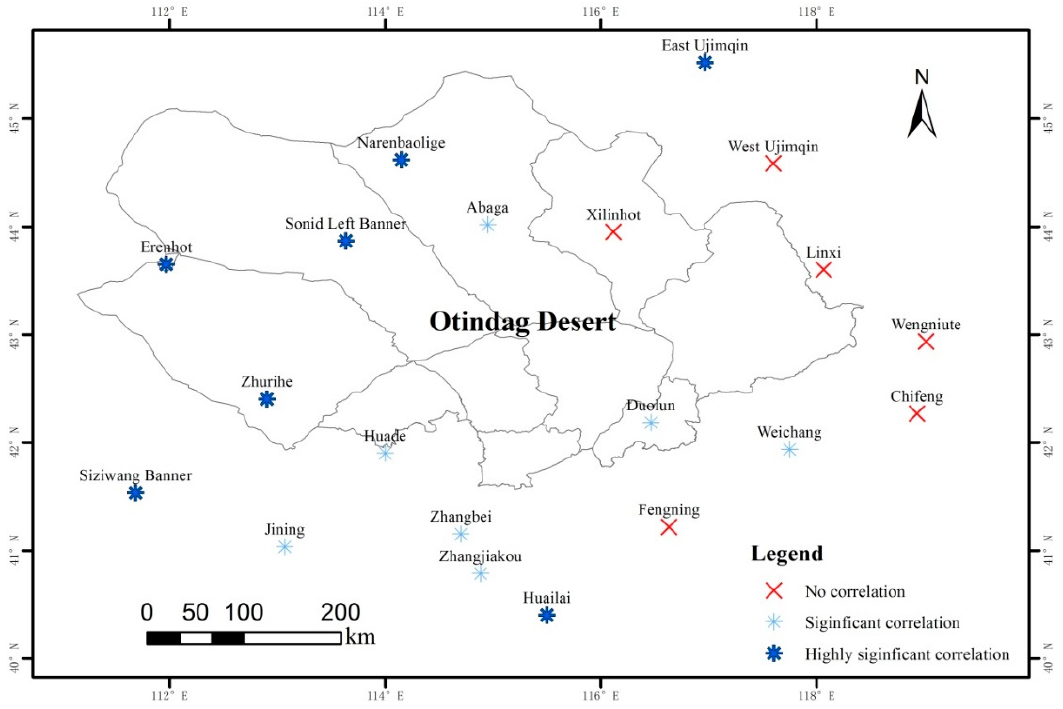
Figure 6. Correlation between annual climatic erosivity and Multivariate ENSO Index (MEI) for 20 weather stations from 1980 to 2016. A red cross shows a non-significant correlation ( p > 0.05), a light blue asterisk represents a significant correlation at p < 0.05, and a larger blue asterisk represents a highly significant correlation at p < 0.01.